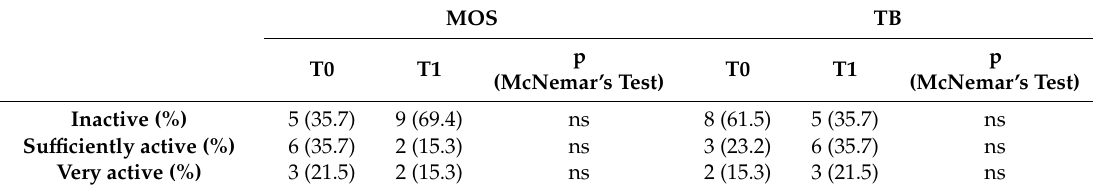
Table 7. International Physical Activity Questionnaire (IPAQ).